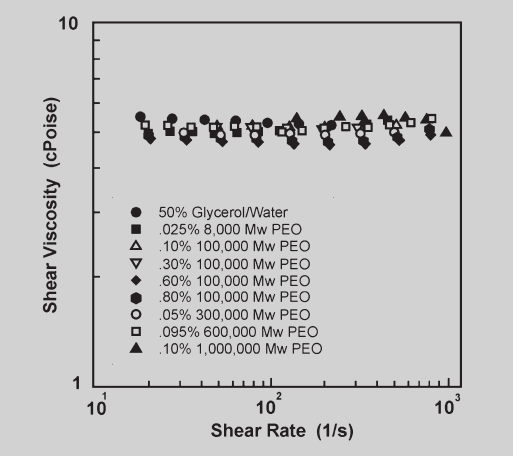
Figure 1 (left): Shear viscosity measure- ments for some representa- tive low viscosity polyethyl- ene solutions. Note: the solutions all have a constant and approxi- mately equal viscosity. Figure 2: Storage modulus, G’, for low viscosity polyacrylamide flu- ids obtained with a Con- traves